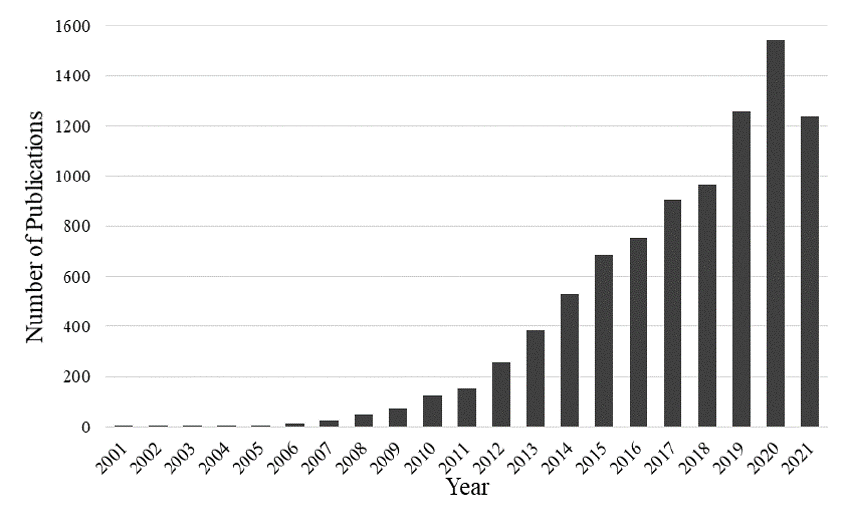
Figure 2: The number of publications in the period 2001-2021 containing the word “graphene quantum dots” in the title, abstract, or keywords. Data source: Scopus (26 th Aug